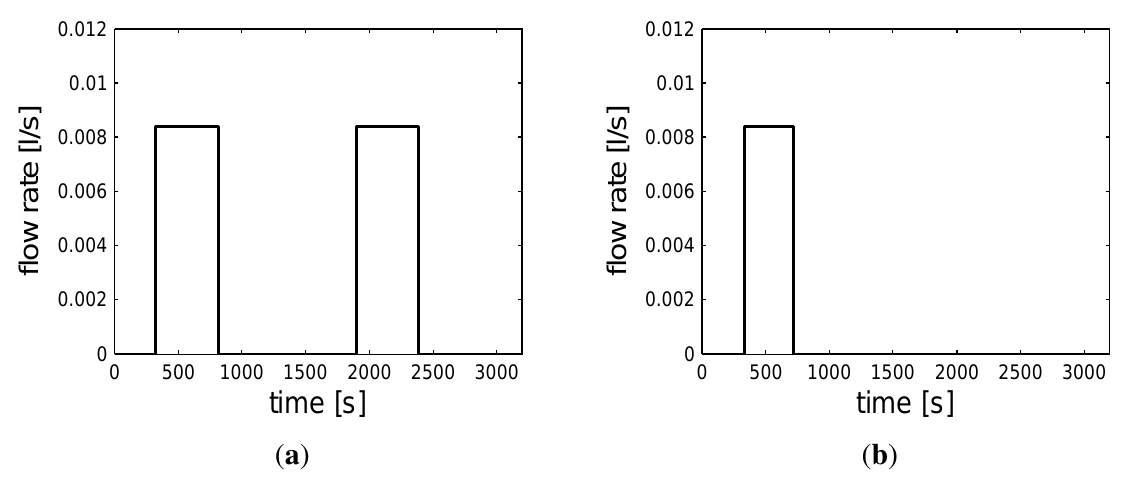
Figure 14. Fuel flow rate of the diesel engine in the HEV. The air cooling system is turned ( a ) on and ( b )